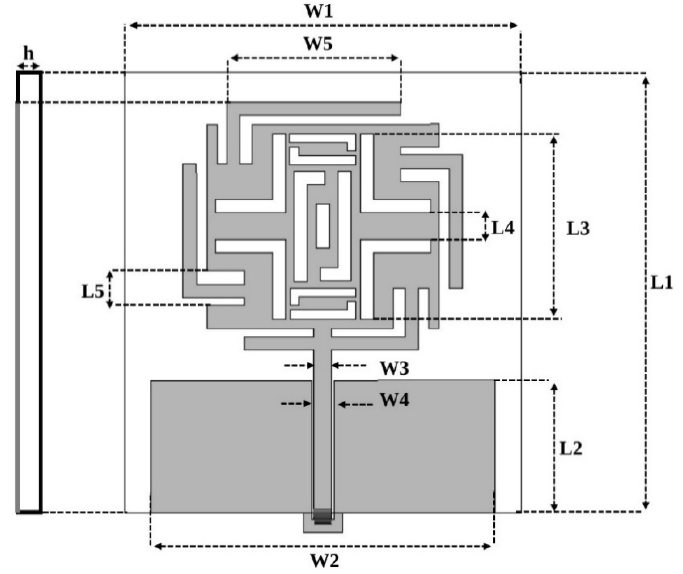
Figure 11. Layout of the dual band wearable antenna.